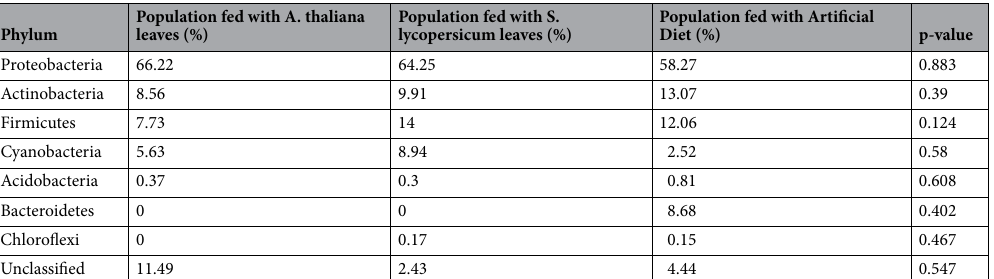
Table 2. Relative abundances of bacteria detected within gut samples of different Trichoplusia ni populations. Bacterial relative abundance percentages were determined by comparing the numbers of ASVs classified at the phyla level to all other detected microbiota within each community. For all phyla, no statistically significant differences were detected between the different communities sampled (p > 0.05).